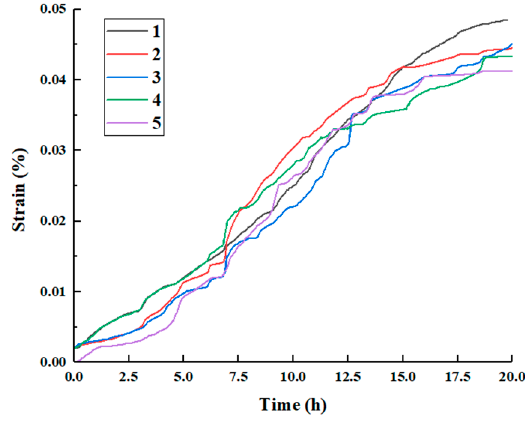
Figure 4. Shrinkage diagram of paste material with time.